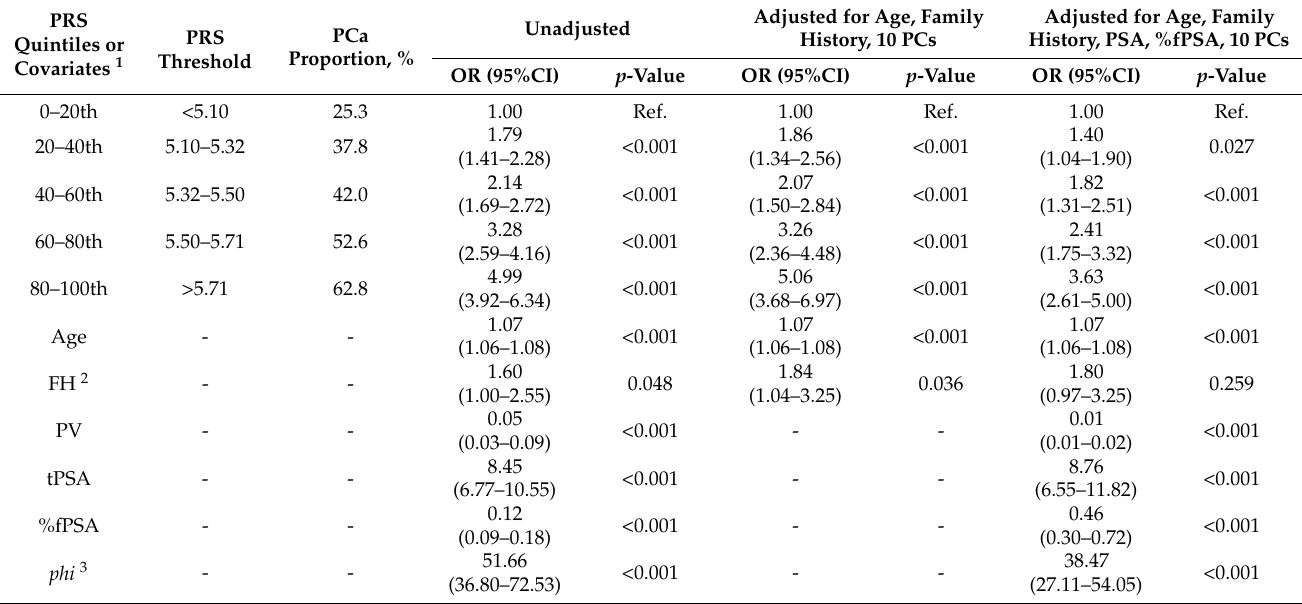
Table 2. Univariable and multivariable associations between categorized polygenic risk score and prostate cancer